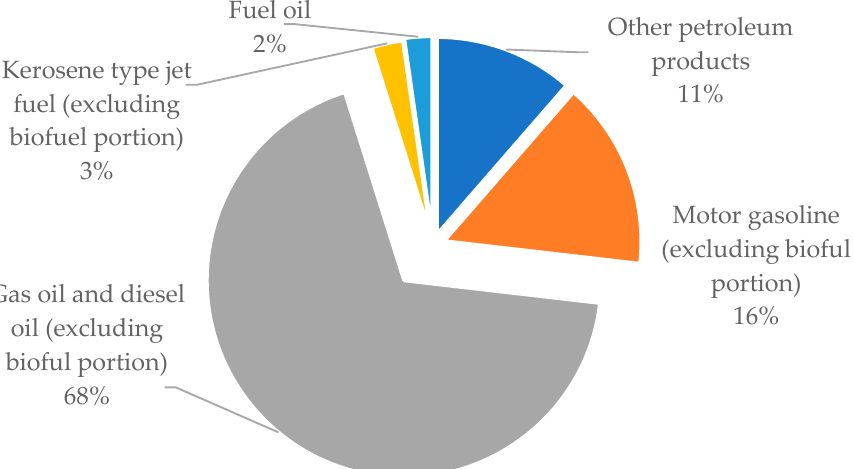
Figure 22. Oil and petroleum products going through final energy consumption–2019 data (adopted from Eurostat data).